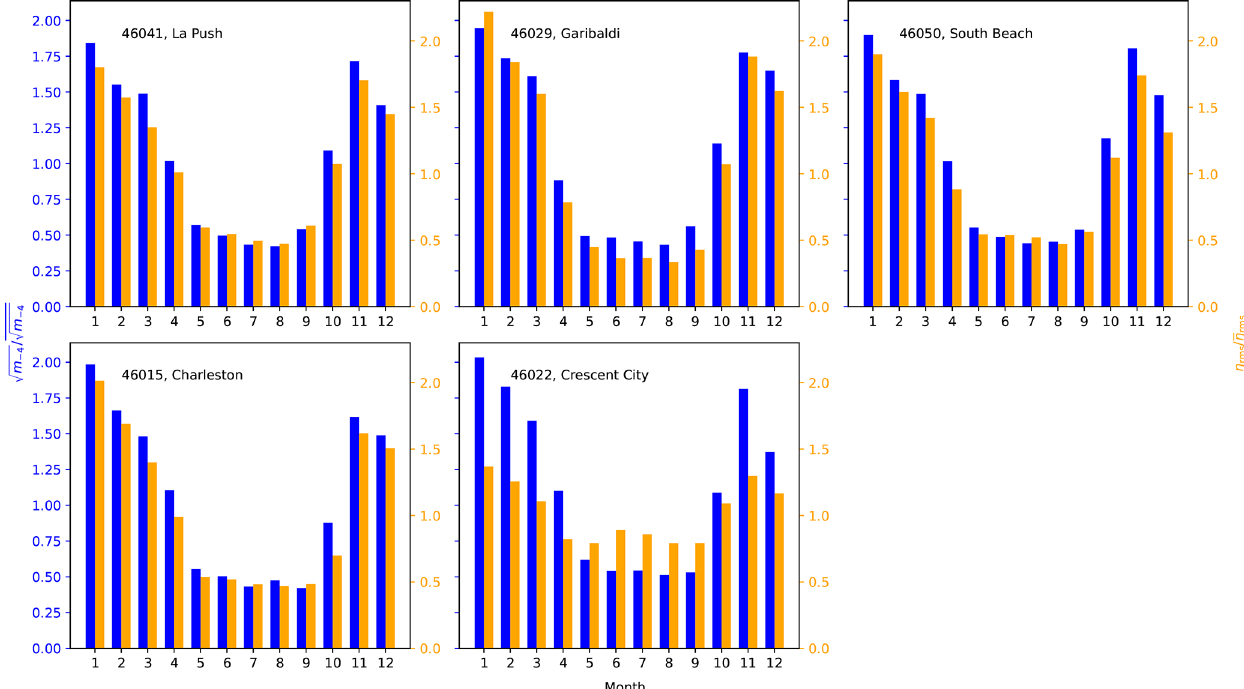
√ √ m − 4 f 2 m 0 (blue) from ocean wave spectra and η rms /η rms (orange) at the tide gages, computed from a 0.5h / m 2